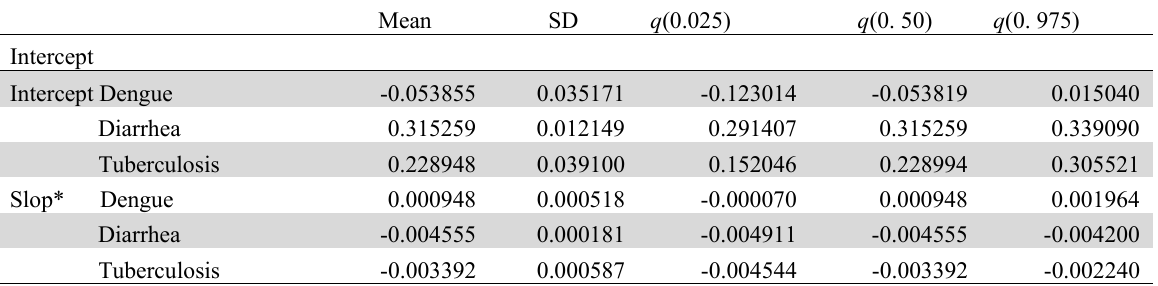
Posterior mean of fixed effect